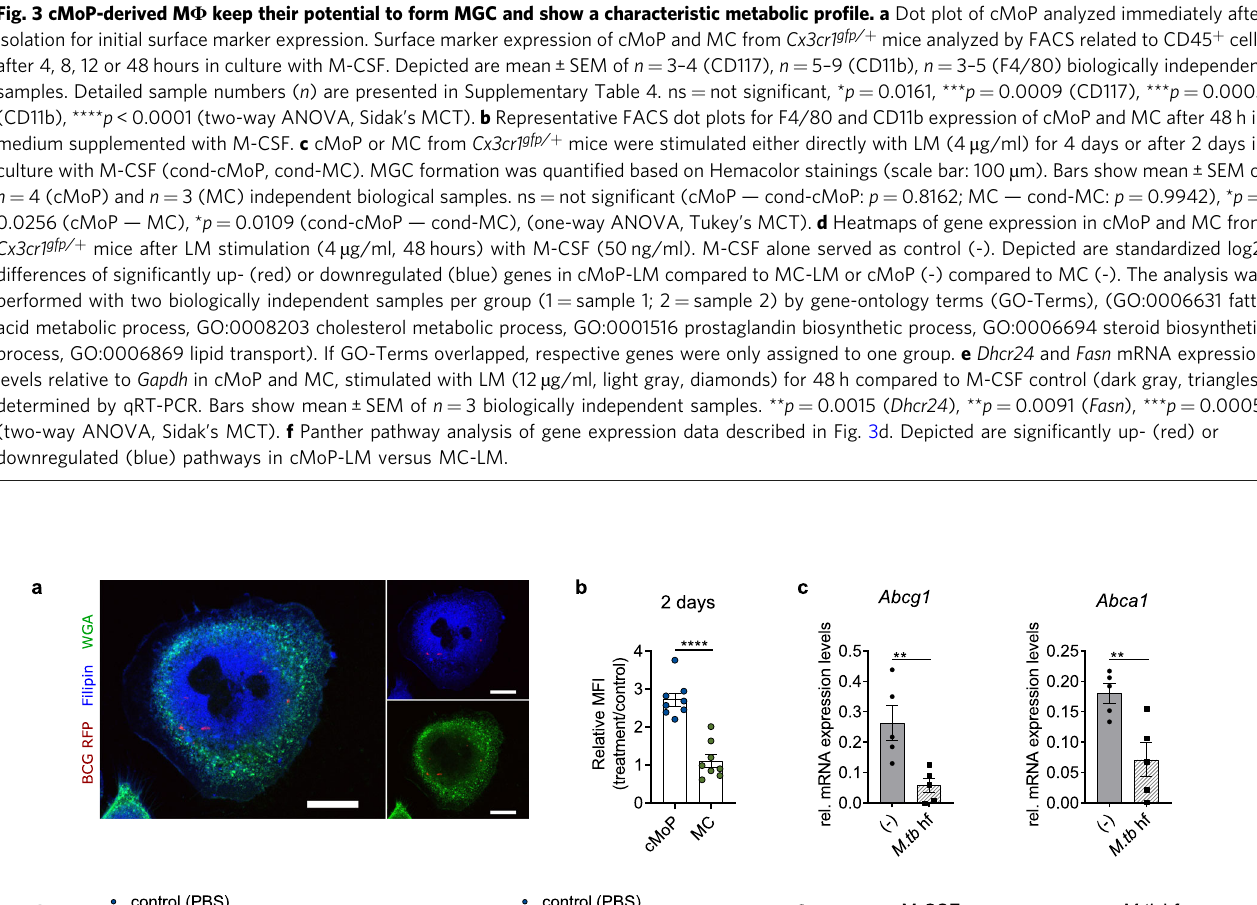
Fig. 4 Cholesterol metabolism is an essential prerequisite for MGC formation. a Filipin (blue) and wheat germ agglutinin (WGA, green) staining of cMoP-derived MGC induced with heat- fi xed (hf) BCG (10 6 /ml) and additionally infected with BCG-RFP (MOI 1, red). Scale bar: 20 µ m. Representative staining out of three independent experiments shown. Channels were adjusted individually with respect to contrast and brightness. b Filipin staining, depicted is the mean fl uorescence intensity (MFI) of cMoP (blue) and MC (green) from Cx3cr1 gfp/ + mice stimulated with hf BCG (10 6 /ml) (treatment) normalized to M-CSF control at day 2. Shown are mean ± SEM of n = 8 biologically independent samples examined over three experiments. **** p < 0.0001 (student´s unpaired t -test, two-tailed). c Abcg1 and Abca1 mRNA expression levels relative to Gapdh mRNA of cMoP stimulated with heat- fi xed M.tb (50 µ g/ml) for 6 days determined by qRT-PCR. Bars show mean ± SEM of n = 5 biologically independent samples. ** p = 0.0099 ( Abcg1 ), ** p = 0.0095 ( Abca1 ), (student´s unpaired t -test, two-tailed). d cMoP from Cx3cr1 gfp/ + mice were stimulated with BCG (MOI 20), heat- fi xed BCG (10 6 /ml) or heat- fi xed M.tb (10 µ g/ml) and treated with cholesterol oxidase (2 mU/ml, beige) or PBS (vehicle, blue) for 6 days. MGC quanti fi cation by Hemacolor staining. Bars show mean ± SEM of n = 17 (-), n = 9 (BCG), n = 15 (BCG hf), n = 12 ( M.tb ) independent biological samples examined over 11 experiments. ns = not signi fi cant ( p = 0.9504), * p = 0.0251, ** p = 0.0052, *** p = 0.0004 (two-way ANOVA, Sidak ’ s MCT). e cMoP from Cx3cr1 gfp/ + mice stimulated with heat- fi xed BCG (10 6 /ml) or heat- fi xed M.tb (10 µ g/ml) and treated with methyl- β -cyclodextrin (MBCD, 1 mmol, beige) or dH 2 O (vehicle, blue) for 6 days. MGC quanti fi cation by Hemacolor staining. Bars show mean ± SEM of n = 20 (-), n = 8 (BCG), n = 7 ( M.tb ) biologically independent samples. ** p = 0.0038, **** p < 0.0001 (two-way ANOVA, Sidak ’ s MCT). f cMoP from Cx3cr1 gfp/ + mice were stimulated with heat- fi xed M.tb (10 µ g/ml) and treated with methyl- β -cyclodextrin (MBCD, 1 mmol), LDL (50 µ g/ml) or PMA (1 µ g/ml) for 6 days. Vehicle control for MBCD was dH = 15 2 O. Bars show mean ± SEM of n biologically independent samples in seven experiments (M-CSF control) and n = 7 biologically independent samples in three experiments ( M.tb ). * p < 0.05, *** p = 0.0004, **** p < 0.0001 (one-way ANOVA, Tukey ’ s MCT).